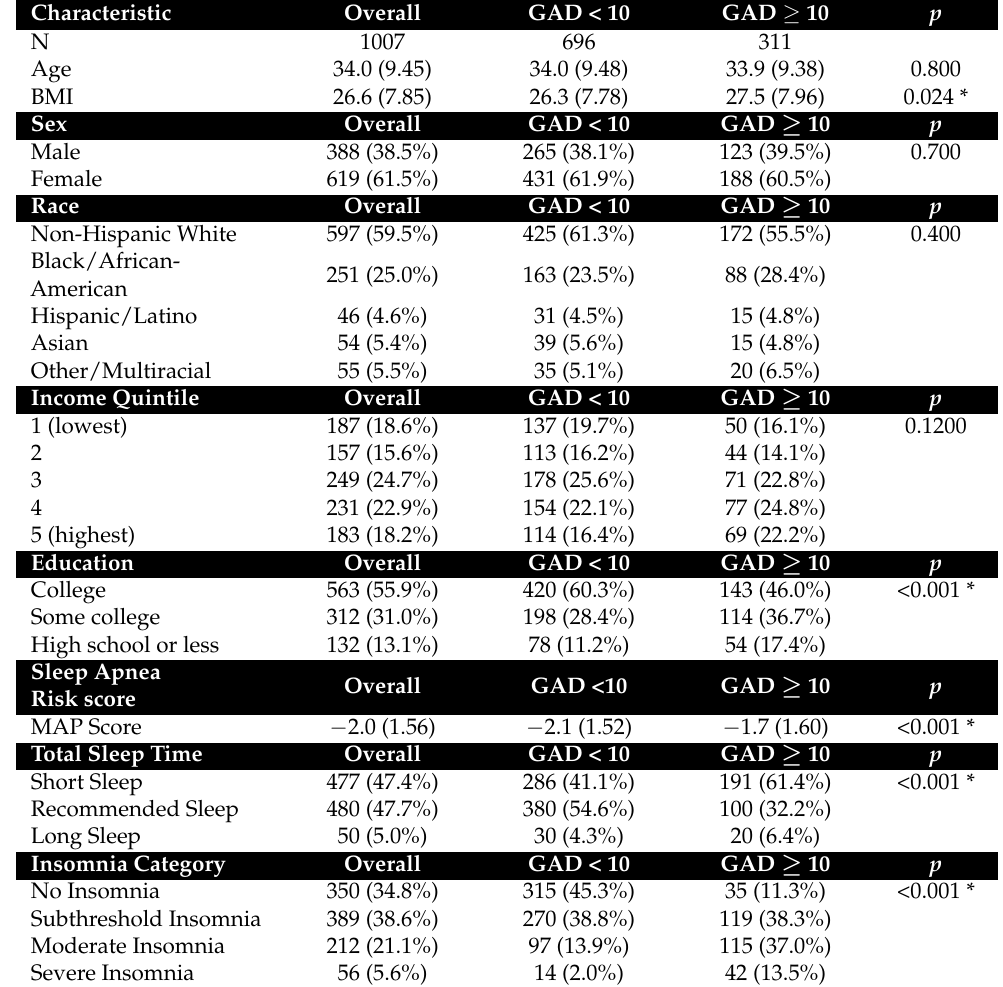
Table 1. Characteristics of the sample by severity of